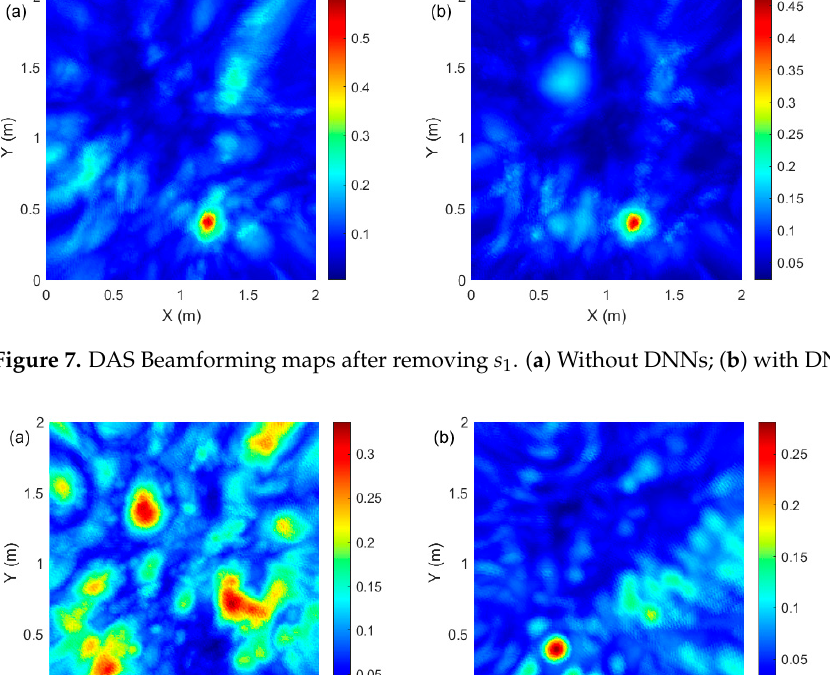
Figure 8. DAS Beamforming maps after removing s 1 and s 2 . ( a ) Without DNNs; ( b ) with DNNs.